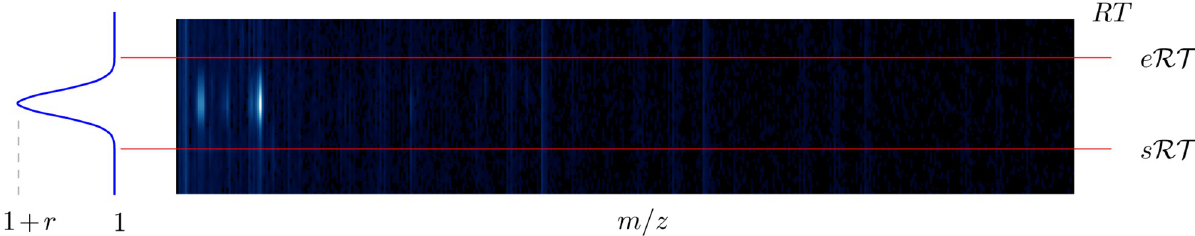
Fig 7. Scheme of the data augmentation by the intensity variation in VOC the data point. Along RT points containing the VOC pattern (i.e., between s RT and e RT ), the intensities of each m/z channel were multiplied by a Gaussian-shaped function to simulate variations of the VOC